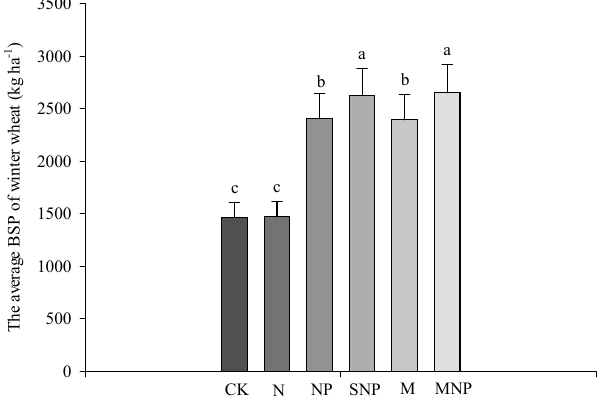
Figure 3. The average basic soil productivity of winter wheat under different fertilizations, 1981–2016. The different lowercase letters indicate significant differences between treatments by LSD (at P < 0.05).